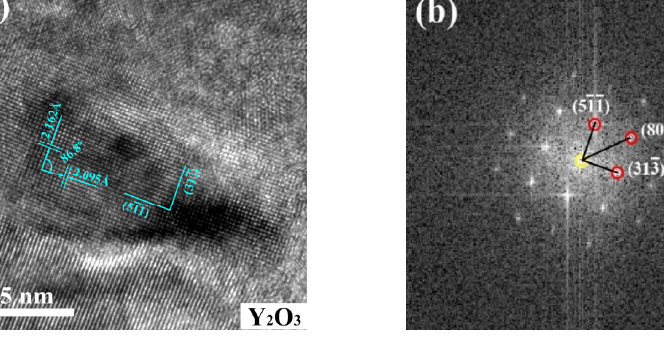
Figure 9. ( a ) High-resolution transmission electron microscopy (HRTEM) image of the Y 2 O 3 nano- particle in 1280-S3 ODS steels; ( b ) FFT diagram micrograph by ( a ); ( c ) IFFT filtered image derived from three adjacent diffraction points in ( b ).